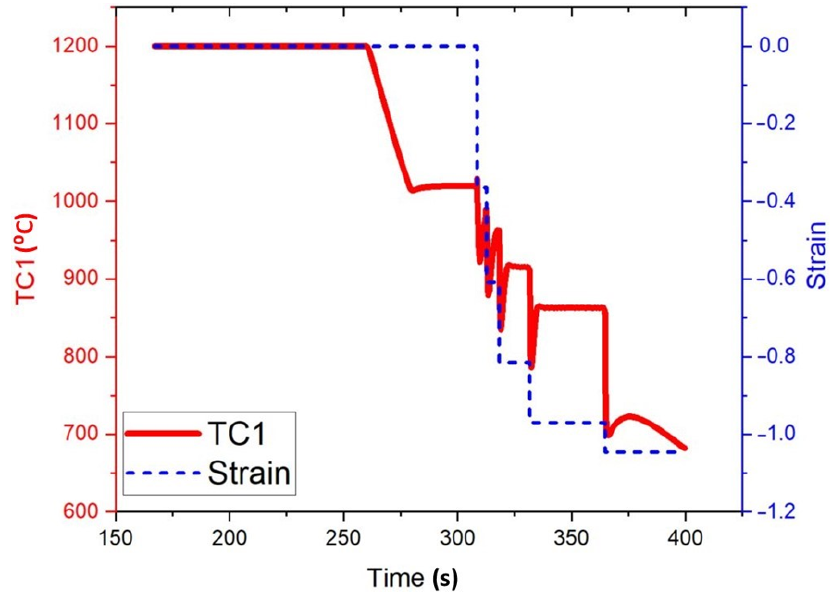
Figure 2. Plane strain hot deformation time/temperature/strain profile for the Variant 3 testing.